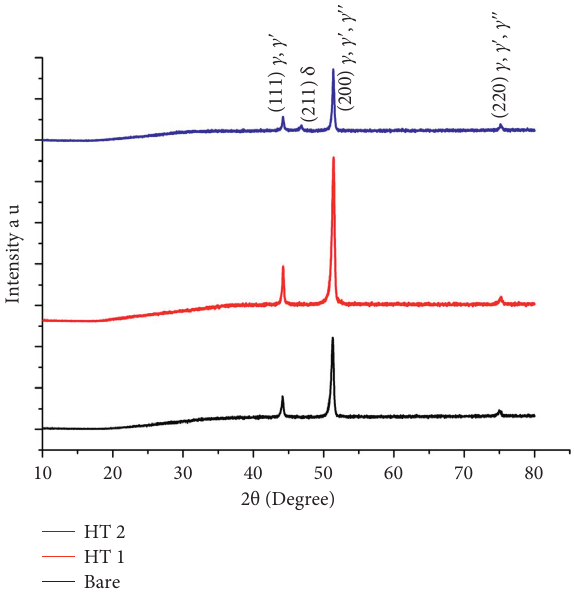
Figure 3: XRD peaks for the heat-treated sample and as built sample with phase